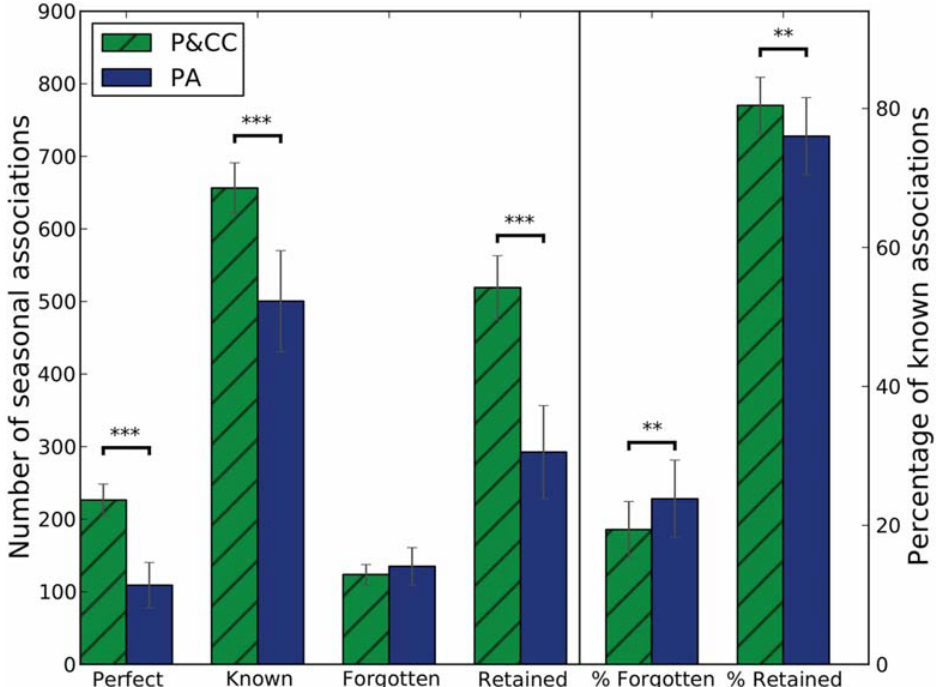
Fig 9. P&CC networks significantly outperform PA networks in both learning and retention. P&CC individuals learn significantly more associations, whether counting only when the associations for both seasons are known ( “ Perfect ” knowledge) or separately counting knowledge of either season ’ s association (total “ Known ” ). P&CC networks also forget fewer associations, defined as associations known in one season and then forgotten in the next, which is significant when looking at the percent of known associations forgotten ( “ % Forgotten ” ). P&CC networks also retain significantly more associations, meaning they did not forget one season ’ s association when learning the next season ’ s association. See text for more information about the “ Perfect ” , “ Known ” , “ Forgotten, ” and “ Retained ” metrics. During all performance measurements, learning was disabled to prevent such measurements from changing an individual ’ s known associations (Methods). Bars show median performance, whiskers show the 95% bootstrapped confidence interval of the median. Two asterisks indicate p < 0.01, three asterisks indicate p <